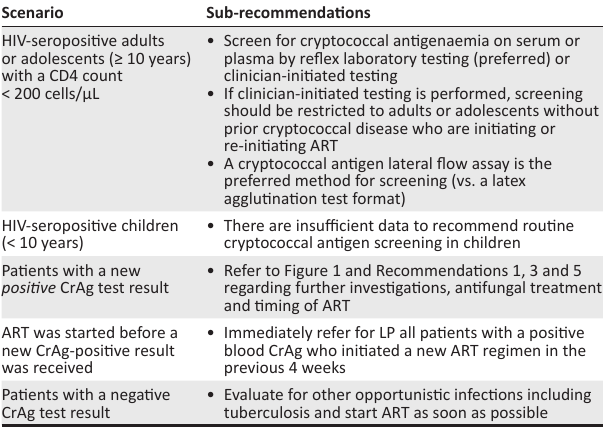
TABLE 1: Summary of recommendation